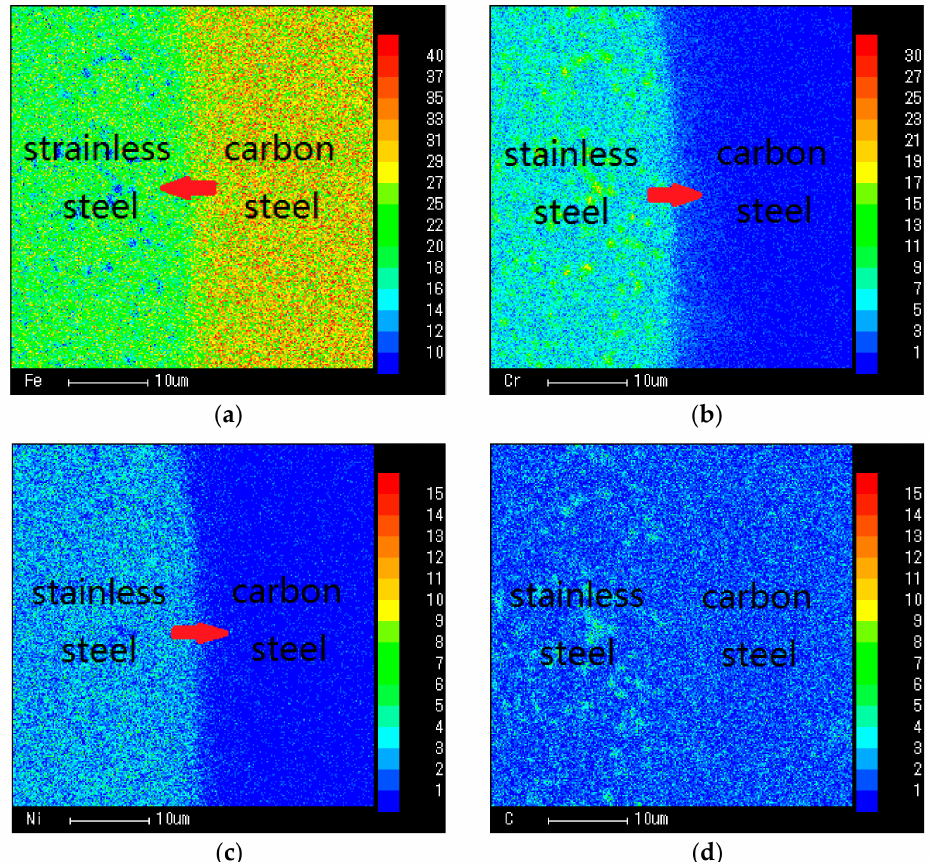
Figure 3. Diffusion and distribution of elements in the transition layer: ( a ) Diffusion and distribution of Fe; ( b ) Diffusion and distribution of Cr; ( c ) Diffusion and distribution of Ni; ( d ) Diffusion and distribution of